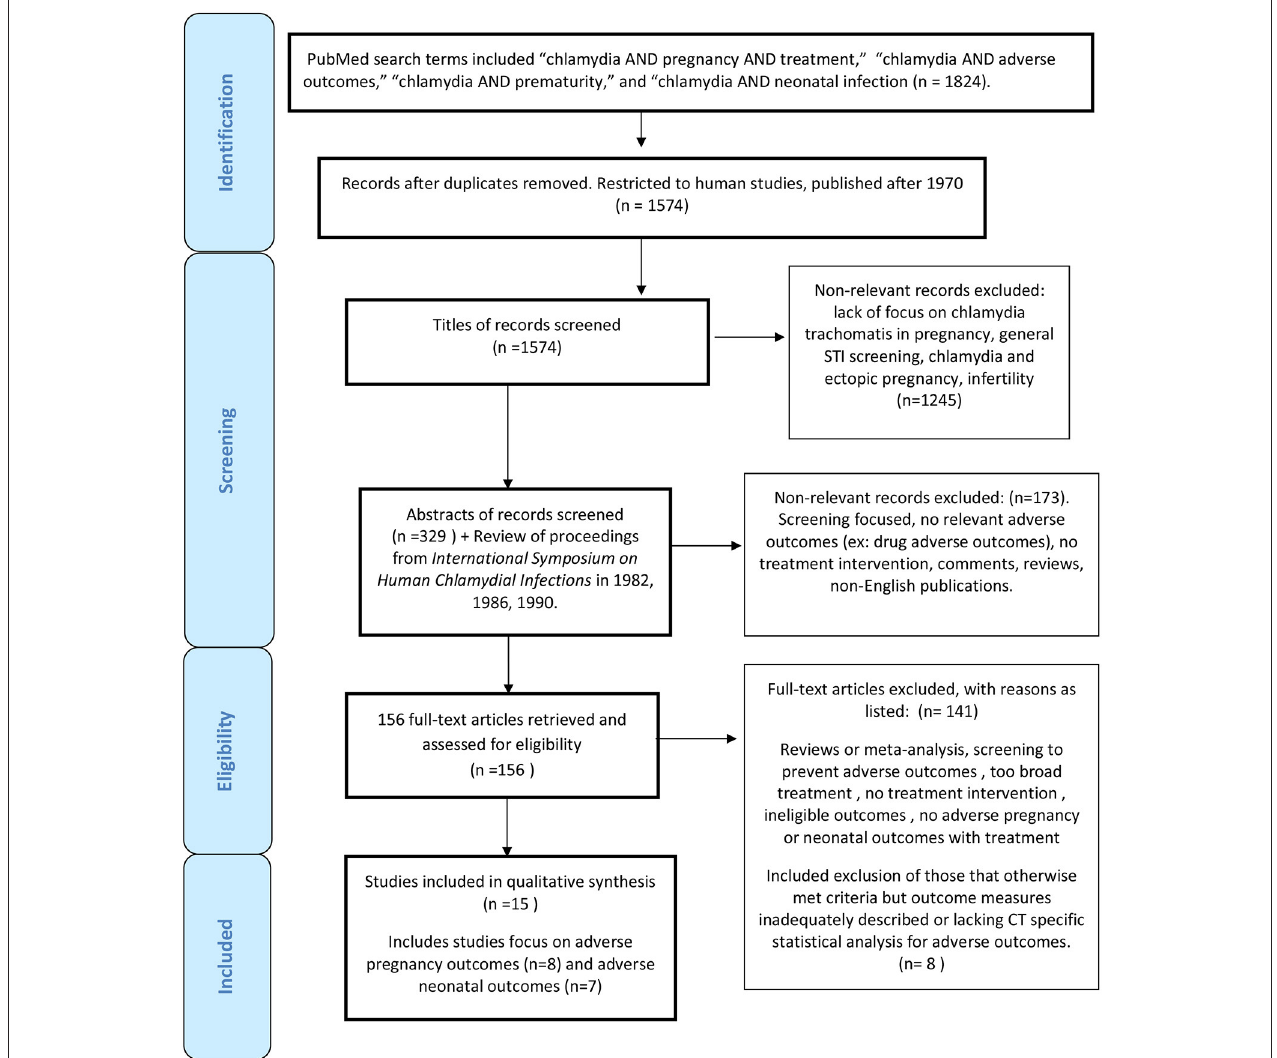
FIGURE 1 | Flow diagram for chlamydial screening and treatment in pregnancy study